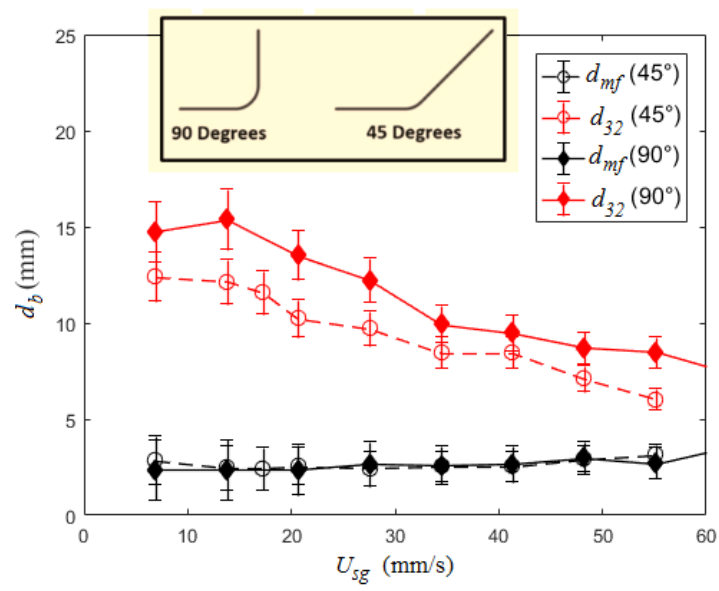
Figure 10. Bubble sizes ( d mf and d 32 ) plotted versus the superficial gas velocity with the injector tube angle either 45° or 90° from horizontal (see insert sketch) ( D = 102 mm; d inj = 0.8 mm; P m = 600 kPa).